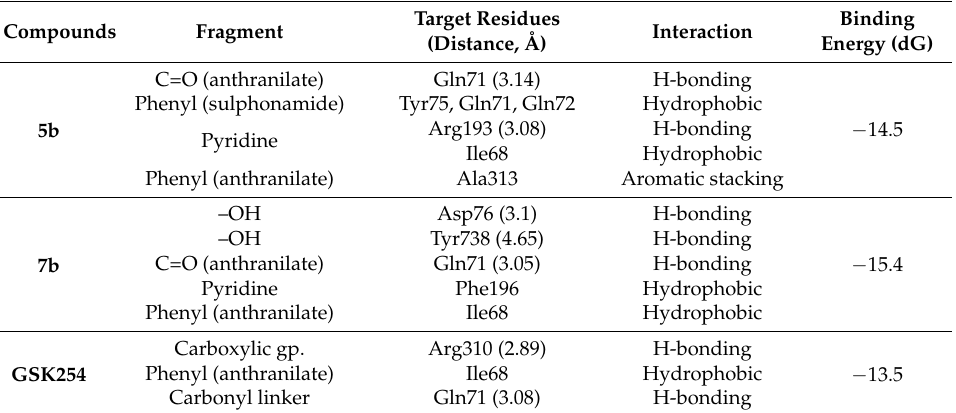
Table 3. Docking data of selected target